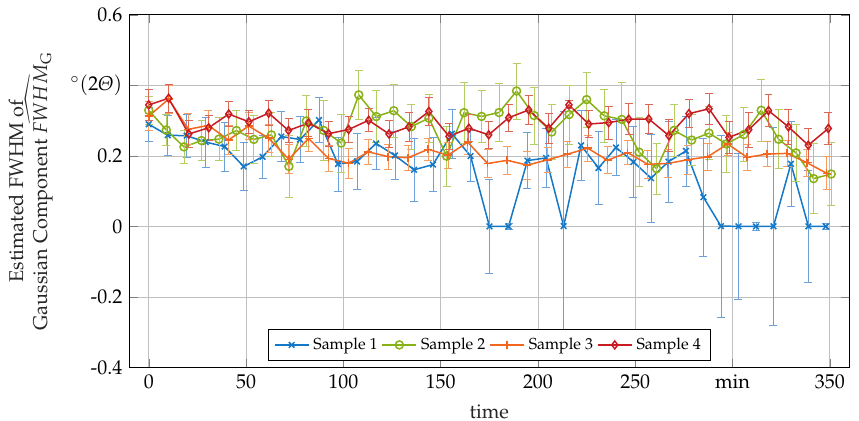
(cid:92) FWHM G of the used Voigt peak shape